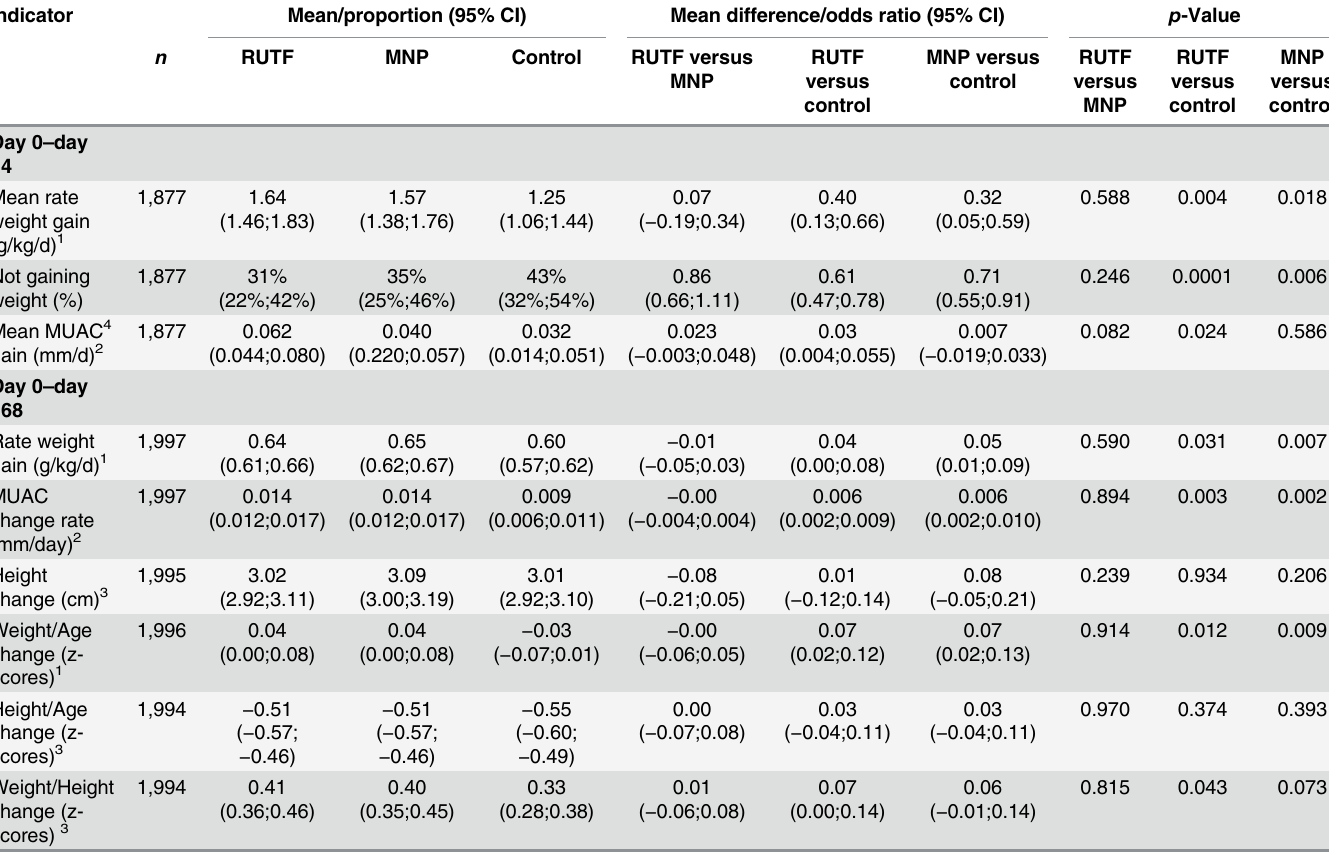
Table 5. Anthropometric indicators: change from baseline to day 14 and day